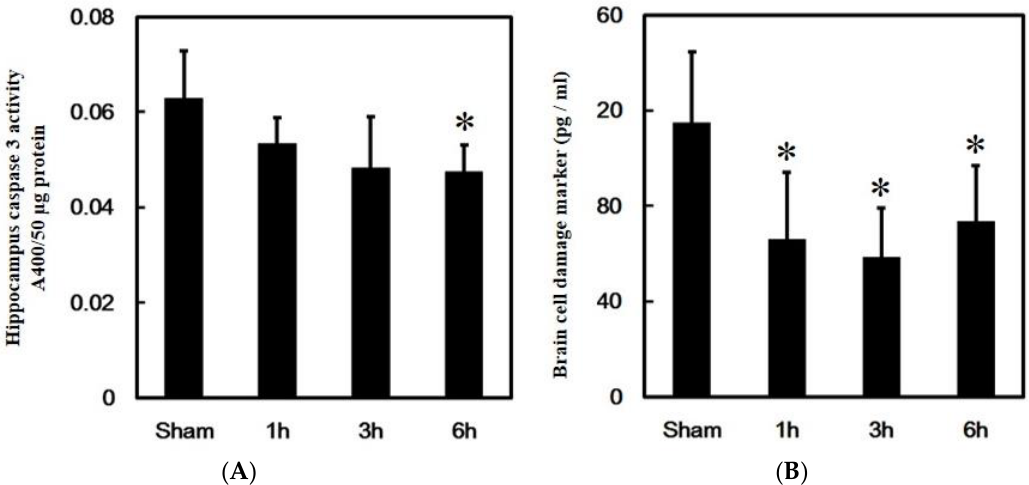
Figure 2. Effects of PPTg DBS on hippocampal cell death. ( A ) Illustration of the apoptosis marker caspase 3 activities evaluated in hippocampal brain tissue. ( B ) Illustration of the brain injury marker MBP levels determined in serum. Both were done at hours 1, 3, and 6-time intervals. Data were presented as mean ± standard deviation (SD) ( n = 6). Significant differences between groups were analyzed using one-way ANOVA. * p < 0.05 was considered statistically significant compared with the sham group.